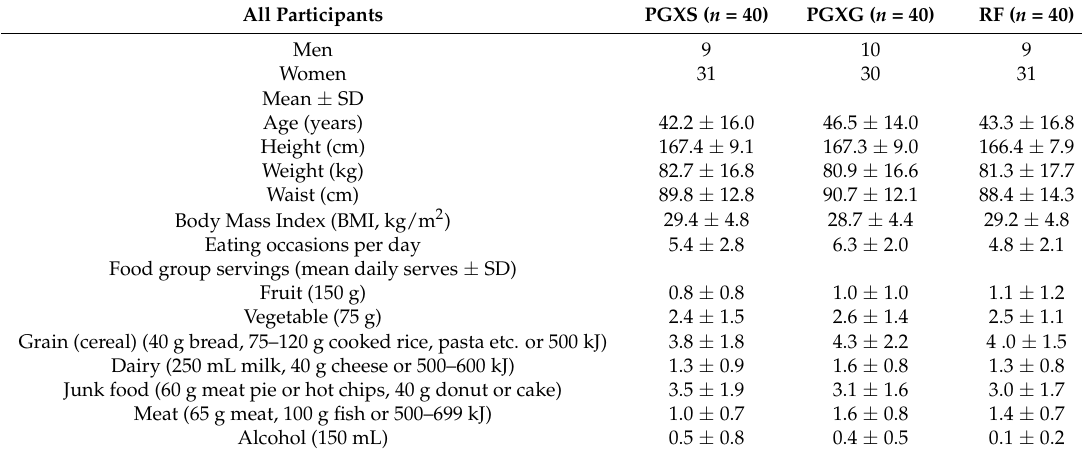
Characteristics of all recruited study participants randomised at baseline ( n = 120) comparing